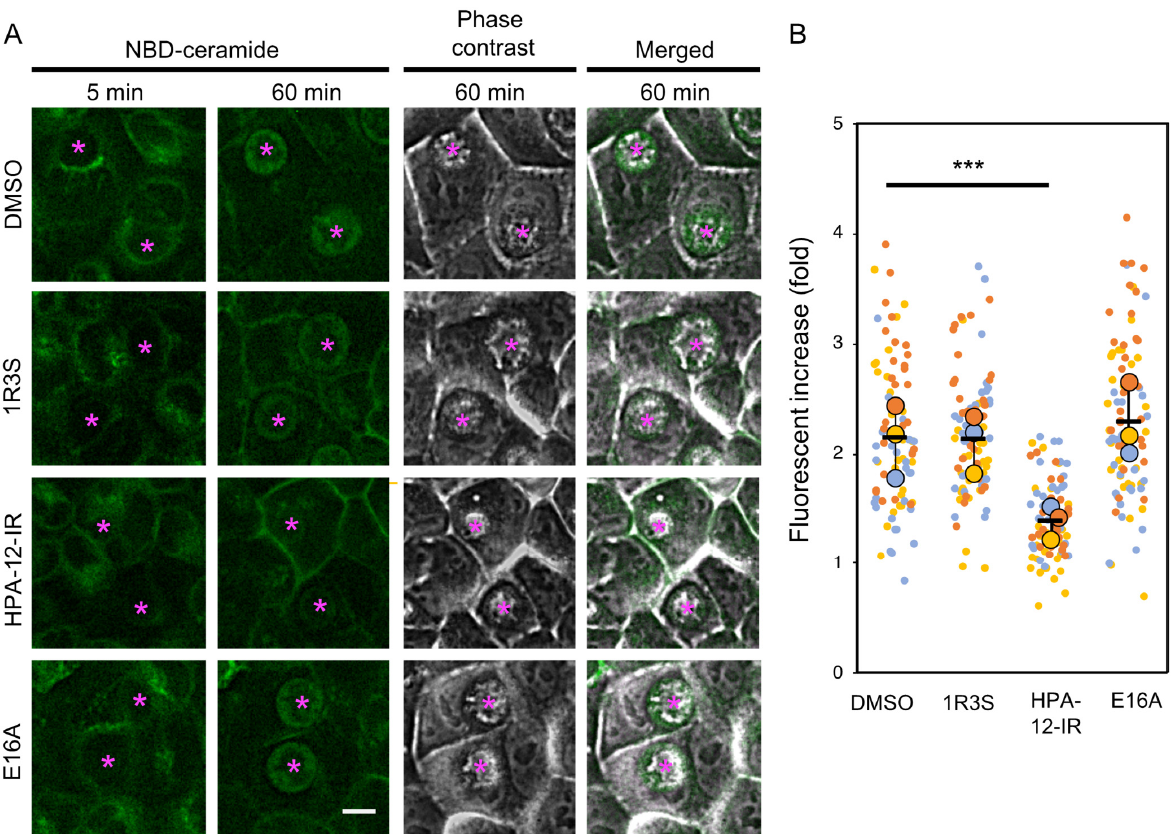
Figure 4. HPA-12-IR inhibited the redistribution of C 6 -NBD-ceramide in the inclusions. ( A ) Chlamydia-infected wild-type HeLa cells were maintained in DMEM/10% FCS for 24 h, then incubated at 4 °C for 30 min in the dark with 5 μ M of C 6 -NBD-ceramide in the presence or absence of 10 μ M of the indicated compound in serum-free FluoroBrite medium. The temperature was shifted to 37